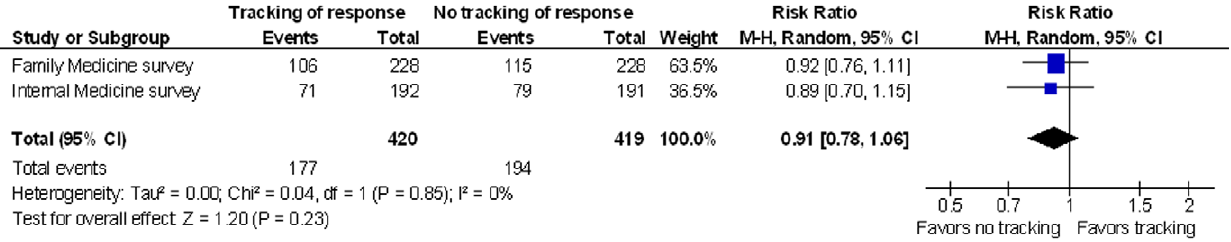
Figure 3. Meta-analysis of response by the time of second reminder comparing tracked vs. non-tracked mailing.